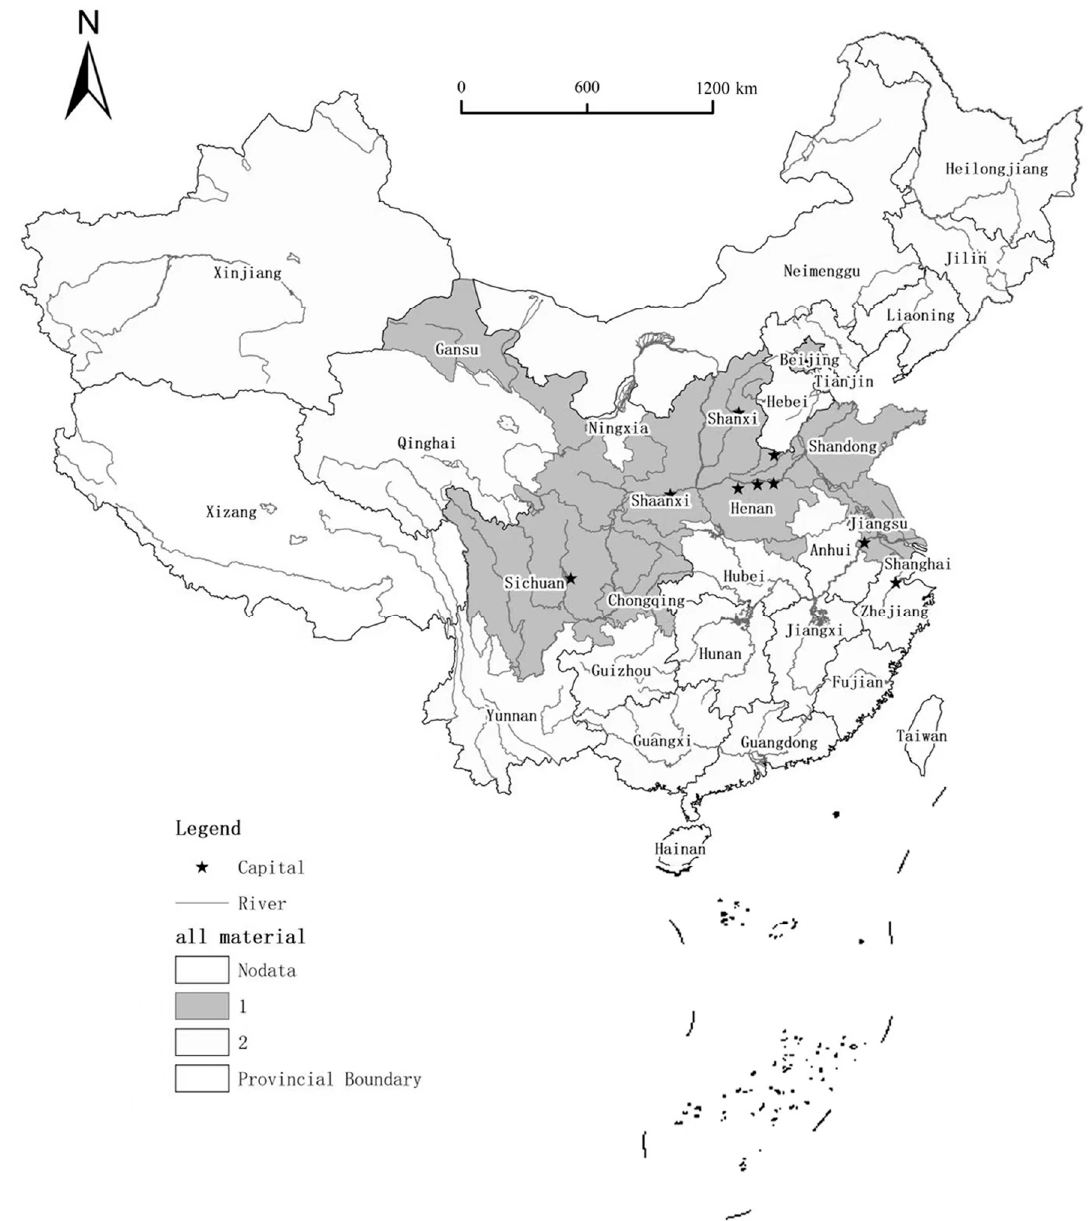
Figure 3. Distribution map of the density of types of relic sites in nine provinces. Selection and Calculation Methods for Kernel Density